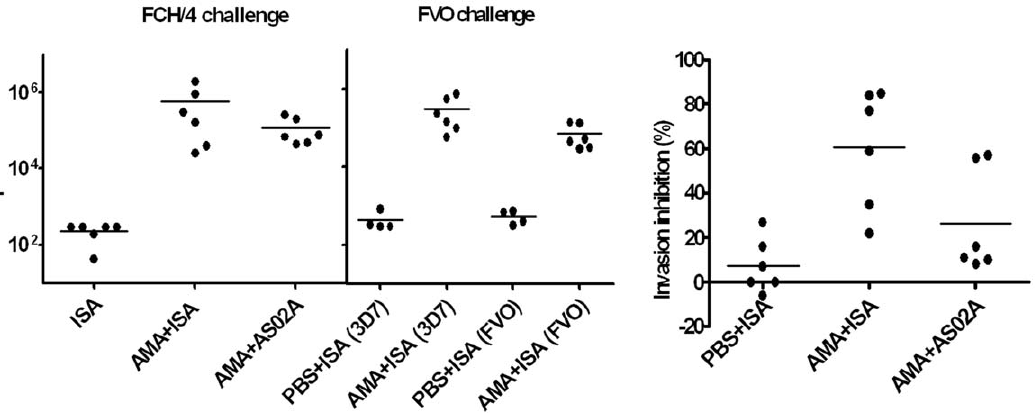
Figure 3. AMA1 + ISA vaccine formulation induced high titer antibodies that inhibited homologous parasite invasion. Left panel shows ELISA endpoint titer of day-of-challenge sera and the group-mean (line). In the FCH/4 challenge group ELISA was done using 3D7 AMA1 coat antigen and for the FVO strain challenge group, ELISA was done using 3D7 and FVO AMA1 coat antigens (shown in parentheses on the x-axis ). Both ELISA panels share the same y axis scale. Right panel shows the GIA activity of the day-of-challenge sera of the FCH/4 challenged groups measured at 10% serum concentration against 3D7 strain parasites.